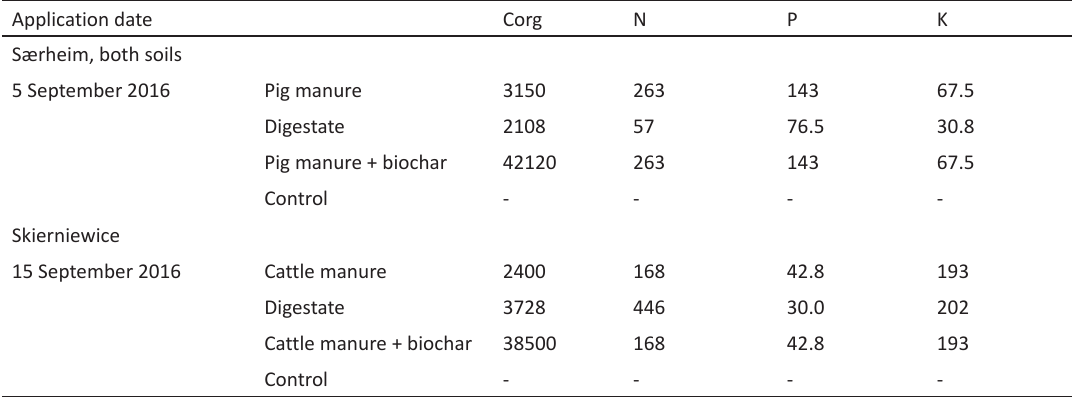
Table 3. Content of organic carbon (Corg), nitrogen (N), phosphorus (P) and potassium (K) in applied organic amendment (kg ha -1 )